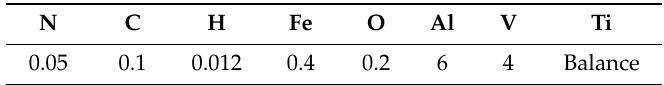
Table 1. Chemical composition of titanium-6aluminum-4vanadium